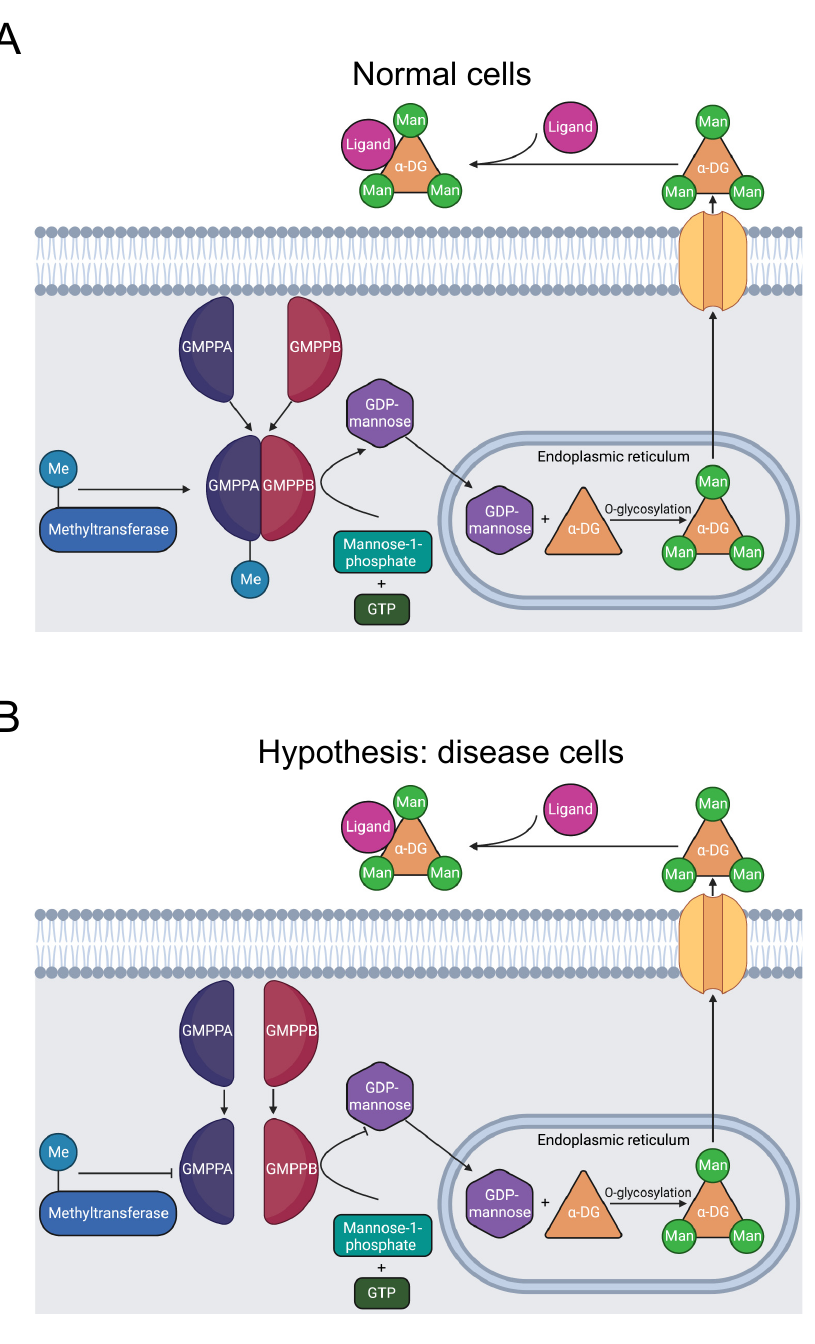
Figure 5. Diagram of GMPPB catalysis of α -DG O-mannosylation. ( A ) GMPPA and GMPPB subunits form a stable complex, including methylation of R357 [31]. The complex catalyzes the reaction of GTP and mannose-1-phosphate that produces GDP-mannose. In the endoplasmic reticulum, GDP-mannose O-mannosylates α -DG. Once transported to the extracellular matrix, α -DG binds to ligands and stimulates downstream signaling pathways [94]. ( B ) R357H inhibits R357 methylation and causes MDDG [23,24,95], likely by preventing stable complex formation [98]. The resulting instability reduces the quantity of GDP-mannose produced and decreases O-mannosylation of α -DG, causing MDDG [94,99,100].